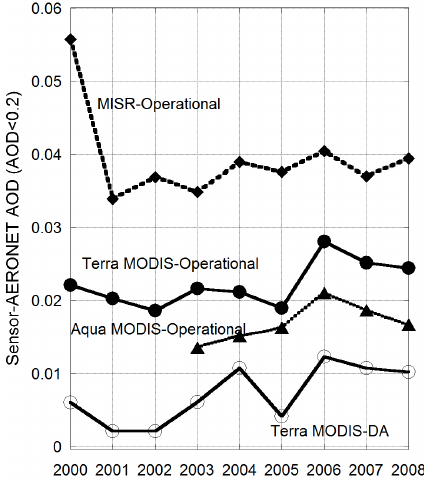
Figure 4 Fig. 4. The yearly averaged differences between the over water satellite AOD values and the AERONET AOD values ( 1 AOD) for the Terra MODIS (operational, filled circles), Aqua MODIS (op- erational, filled triangles), Terra MISR (filled diamonds), and the DA quality MODIS over water aerosol product (open circles). Each open/filled symbol represents a yearly mean of 1 AOD for all the island and coastal sun-photometer sites for AERONET AOD less than 0.2.